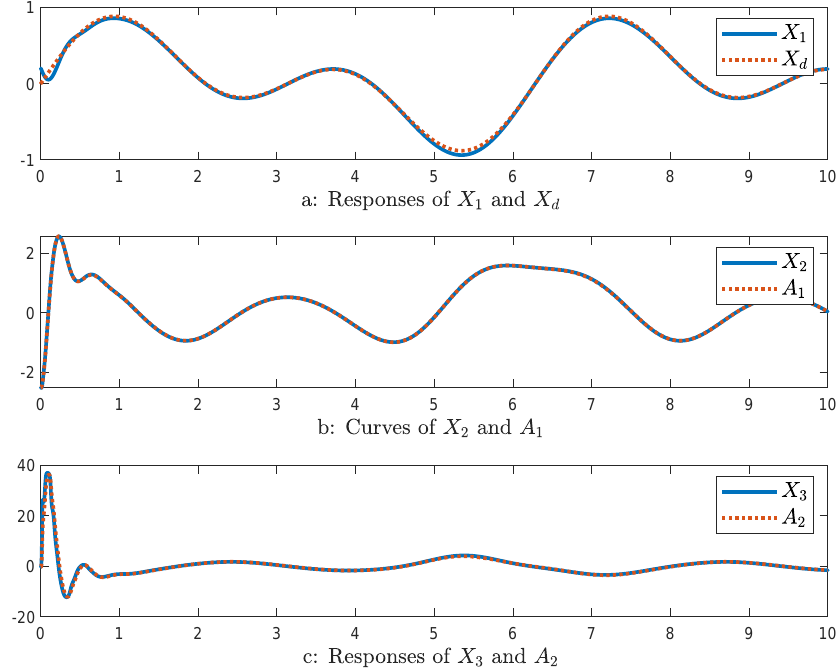
Figure 3. Output tracking performance.